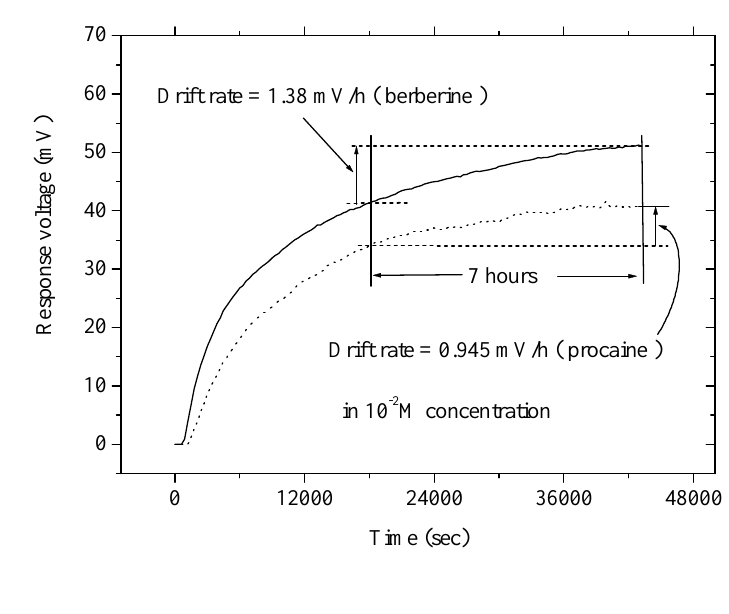
Figure 5. Drift rates of procaine and berberine drug sensors based on ruthenium dioxide membrane in 10 -2 M concentration measurement between 5 and 12